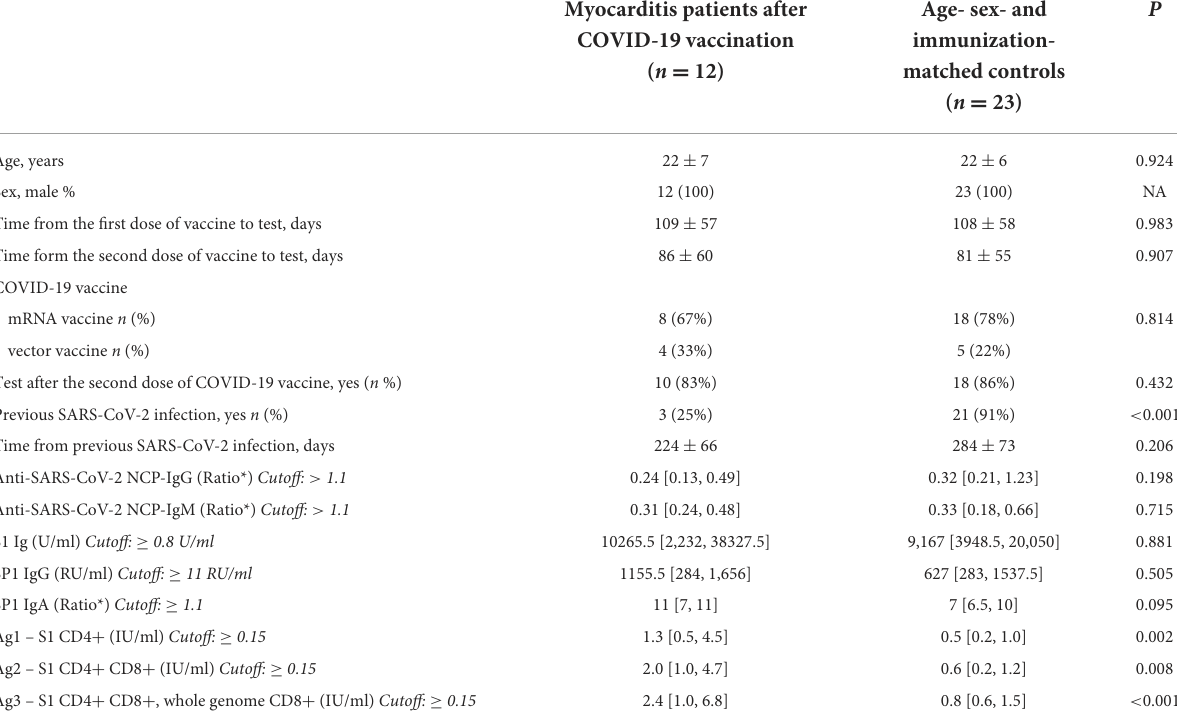
TABLE 5 Immune response in myocarditis patients after COVID-19 immunization vs. age-, sex- and COVID-19 immunization-matched controls. Myocarditis patients